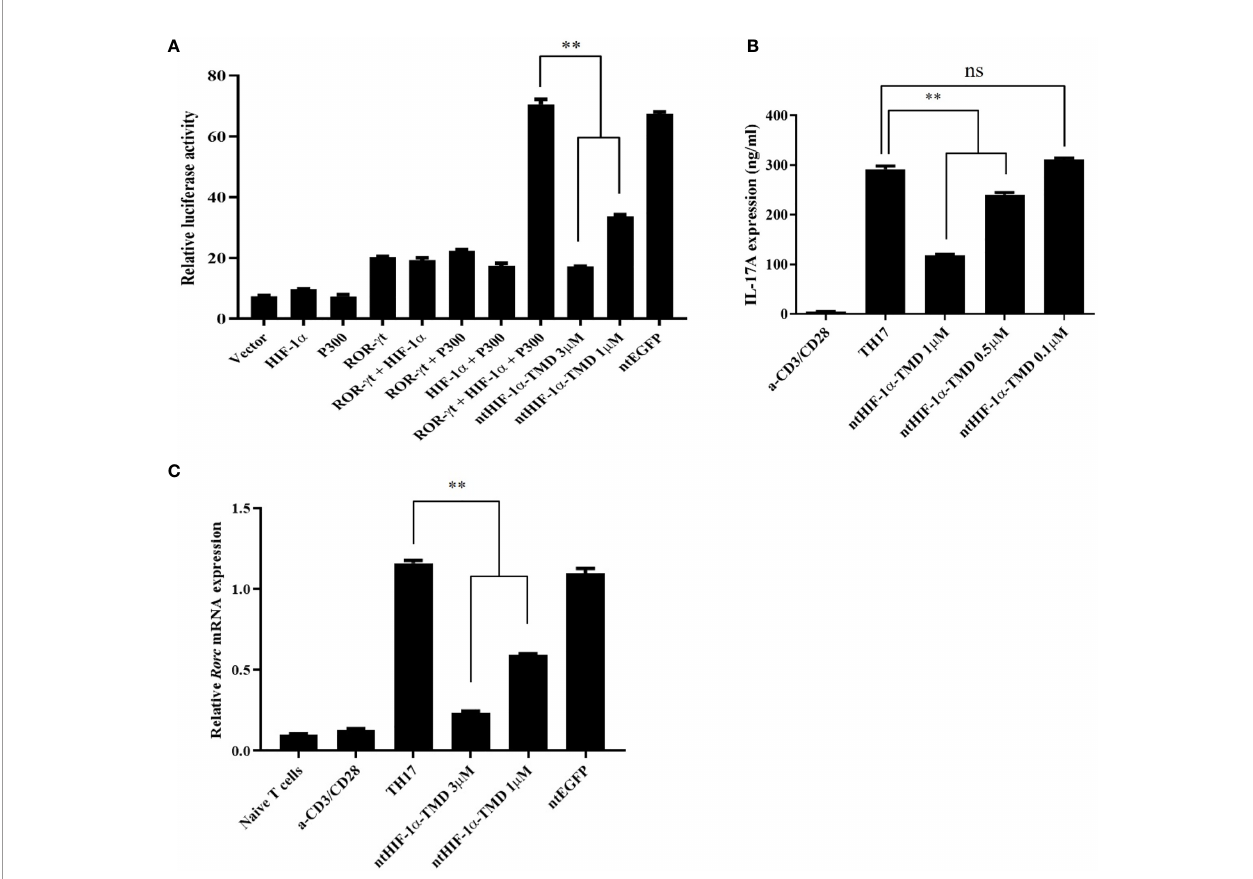
FIGURE 2 | Inhibitory effect of ntHIF-1 a -TMD on differentiation and function of TH17 cells. (A) Jurkat T cells were transfected with the plasmid containing the luciferase reporter gene whose expression is driven by the IL-17 promoter or the indicated gene. Luciferase activity was measured after ntHIF-1 a -TMD treatment. (B , C) After incubation of naïve CD4+ T cells for 3 days in TH17-skewing condition, the level of secreted IL-17A in the supernatant was measured by ELISA. qRT- PCR was performed to evaluate the effect of ntHIF-1 a -TMD on Rorc transcription. Experiments were performed in triplicated wells and repeated three times. Data are represented as mean ± SEM ( n ≥ 4). Statistical analysis was performed using Student ’ s t -test. ns, not signi fi cant, **P <